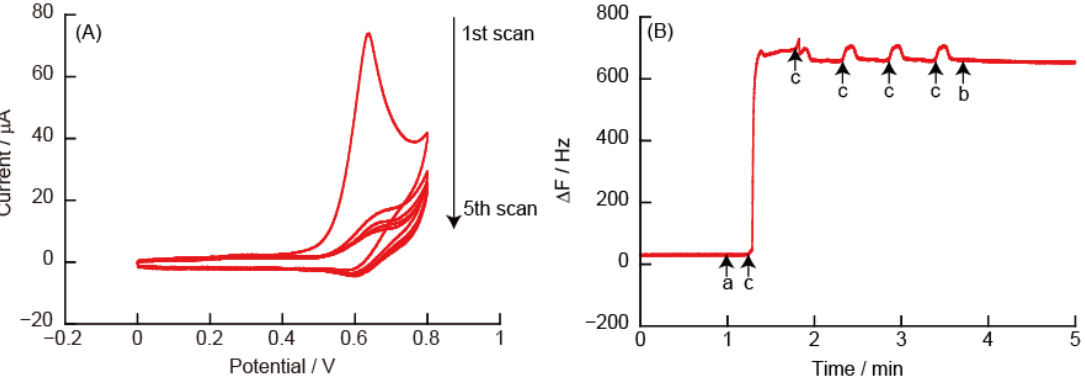
Figure 6. ( A ) Cyclic voltammograms of (PEI/TEMPO-PAA) 5 film in 10 mM HEPES (pH 7, containing 150 mM NaCl), and ( B ) changes in the resonance frequency on the Au resonator in eQCM. The electric potential (scan rate: 50 mV/s, number of sweep scan: 5 cycles) was applied between (a) and (b) in the eQCM, and (c) indicates an oxidation potential of +0.6 V.